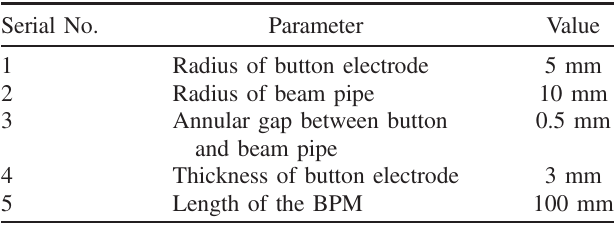
TABLE I. Geometric parameters of the test BPM. Serial No.